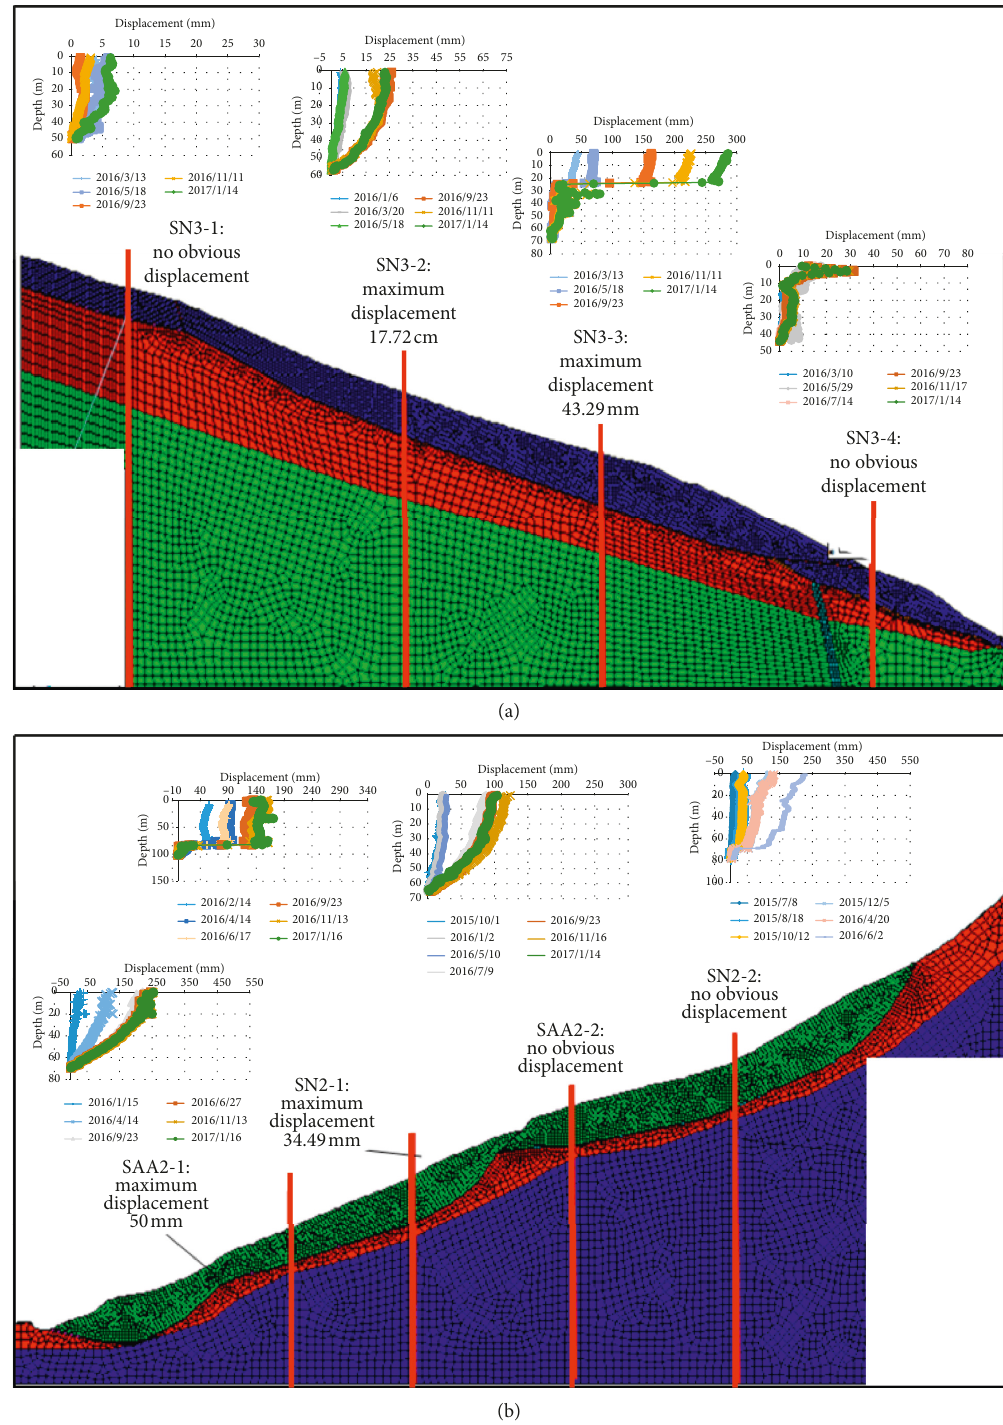
Figure 6: Finite element back analysis models for typical landslide sections. (a) Cangjiangqiao landslide. (b) Dahua